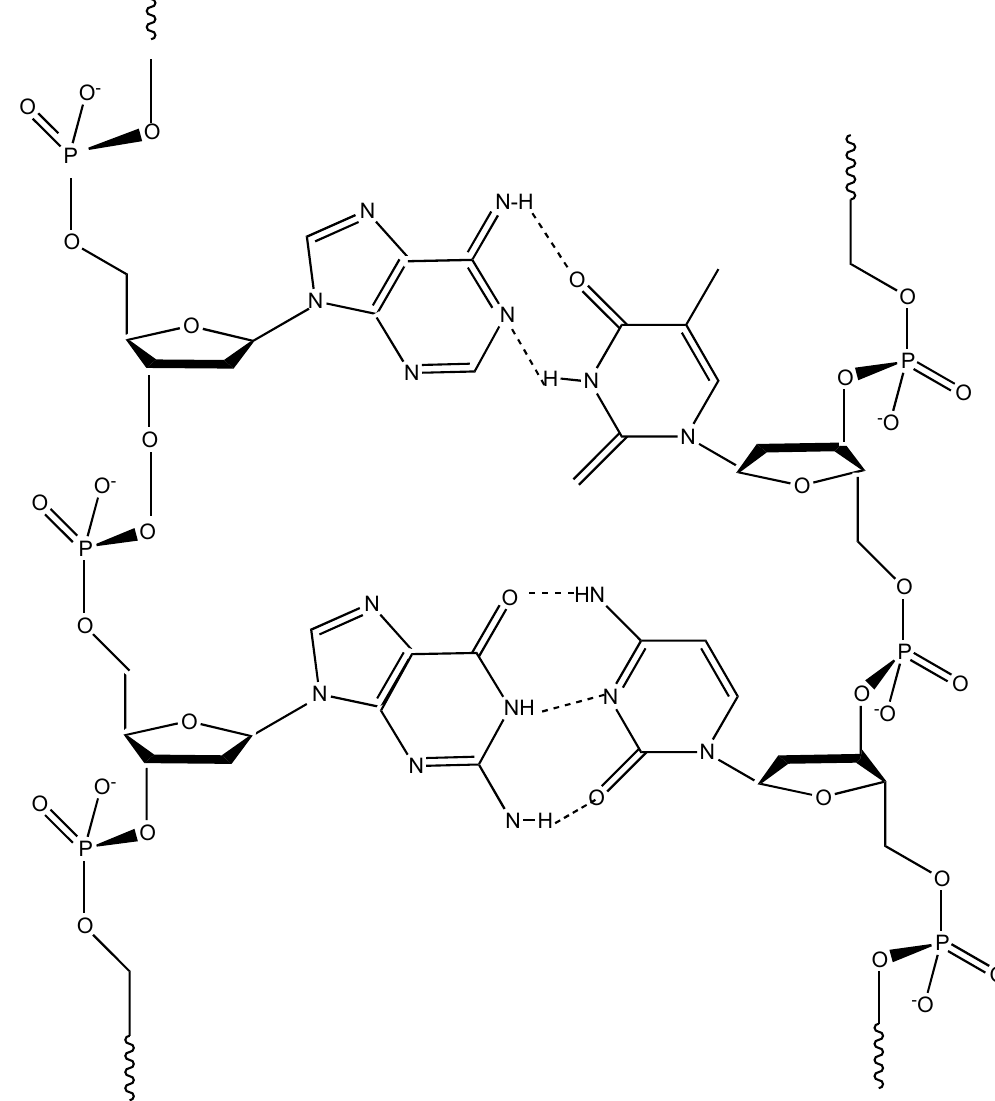
Figure 5. Structure of deoxyribonucleic acids.